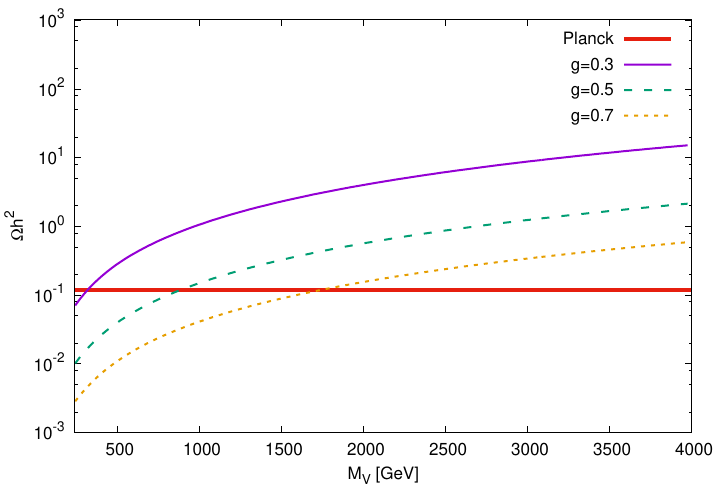
Figure 2 . Relic density as a function of vector DM mass for di(cid:11)ernet values of coupling g